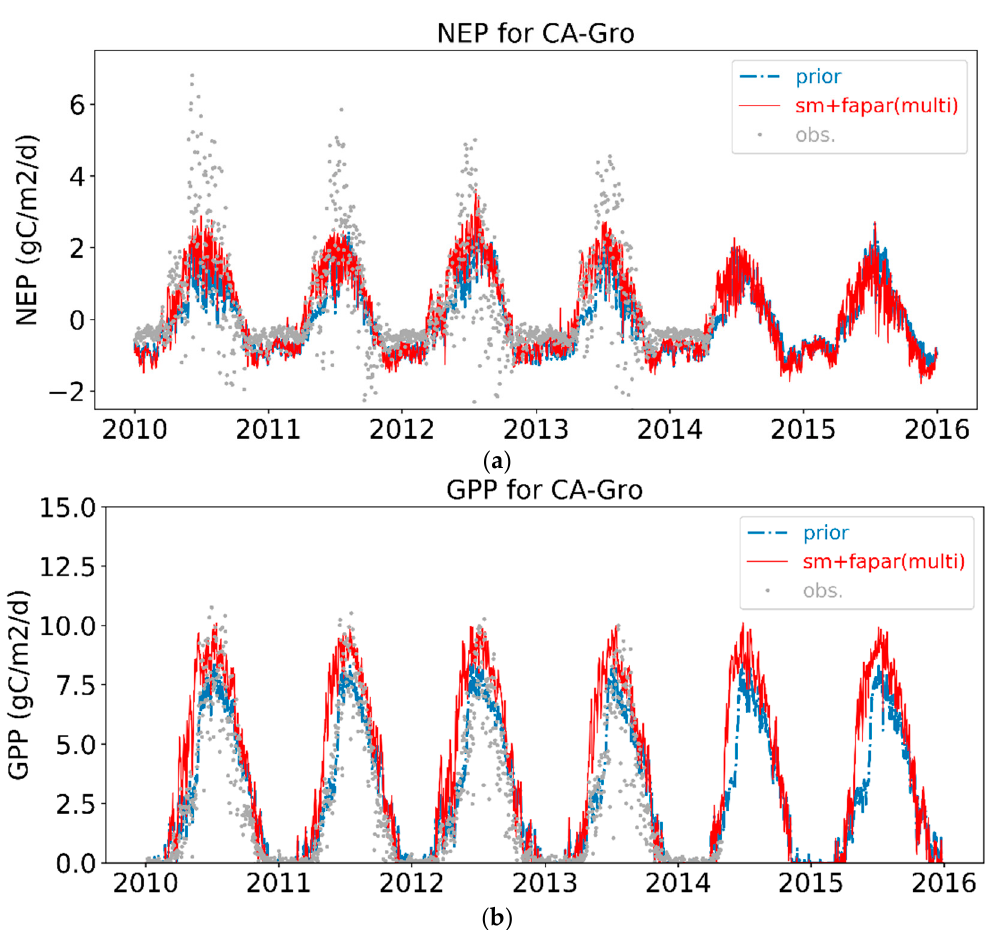
Figure 7. Simulated ( a ) net ecosystem productivity (NEP); ( b ) gross primary productivity (GPP) compared against NEP and GPP data derived from FLUXNET (black dots) at site CA-Gro. The blue line denotes the simulation with the prior parameters, and the red line denotes multi-site assimilation results with both soil moisture and FAPAR used for assimilation (‘sm+fapar (multi)’).